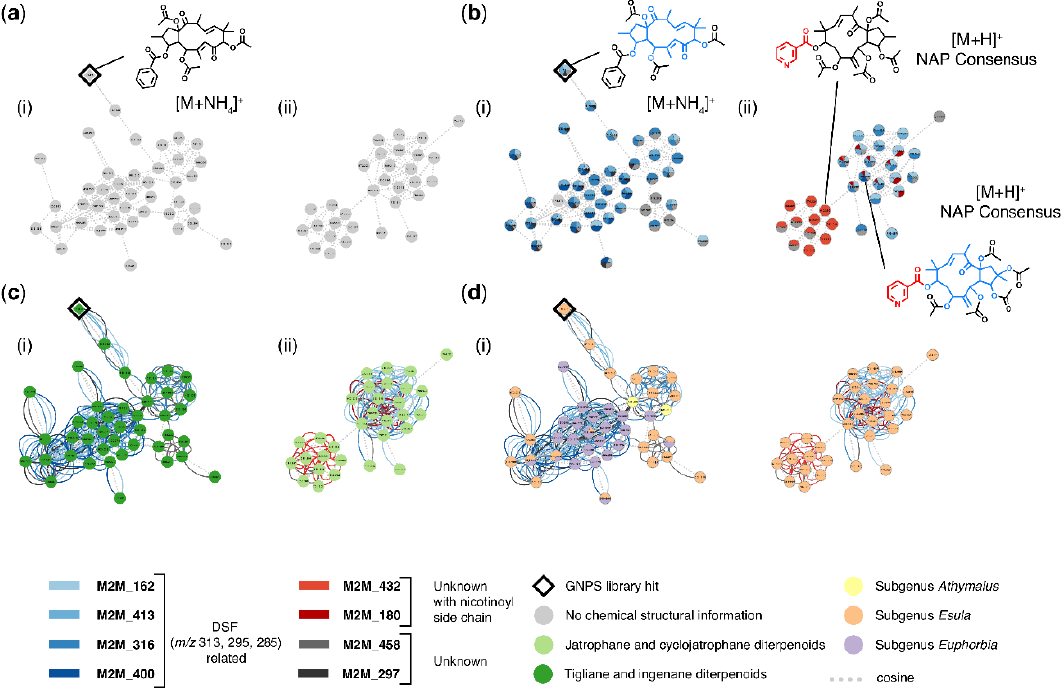
Figure 3. MolNetEnhancer increases chemical structural information obtained for Euphorbia specialized metabolites. ( a ) Mass spectral molecular network showing two molecular families of Euphorbia specialized metabolites. Using GNPS library matching only one molecular feature could be putatively annotated. Manual annotation propagation is limited for family (i) and impossiblefor family (ii). ( b ) Using MolNetEnhancer, substructural Mass2Motifs can be visualized within the network; both molecular family (i) and (ii) contain Mass2Motifs related to a Euphorbia diterpene spectral fingerprint (DSF) and molecular family (ii) contains Mass2Motifs related to a nicotinoyl side chain. Mass2Motifs are mapped on the nodes as pie charts with an area proportional to their overlap score, a score measuring how much of the Mass2Motif is present in the spectrum, whereas dotted lines connecting the nodes represent features with a MS2 spectral similarity of a cosine score over 0.6 ( c ) Most chemical structures retrieved for molecular family (i) and (ii) are diterpenoids of the jatrophane, tigliane or ingenane type, which both can result in a DSF with m / z 313, 295, or 285. Substructures with mass fragments characteristic of these Euphorbia DSFs were also found within the Mass2Motifs. Node colors represent most abundant chemical classes, colored lines connecting the nodes represent shared Mass2Motifs, and dotted lines connecting the nodes represent features with a MS2 spectral similarity of a cosine score over 0.6 ( d ) Euphorbia diterpenoid skeletons of the jatrophane, deoxy tigliane, or ingenane ester type are found within all Euphorbia subgeneric clades, whereas nicotinoyl sidechain modifications are unique to subgenus Esula . Node colors represent summed peak area per Euphorbia subgeneric clade, colored lines connecting the nodes represent shared Mass2Motifs, and dotted lines connecting the nodes represent features with a MS2 spectral similarity of a cosine score over 0.6.